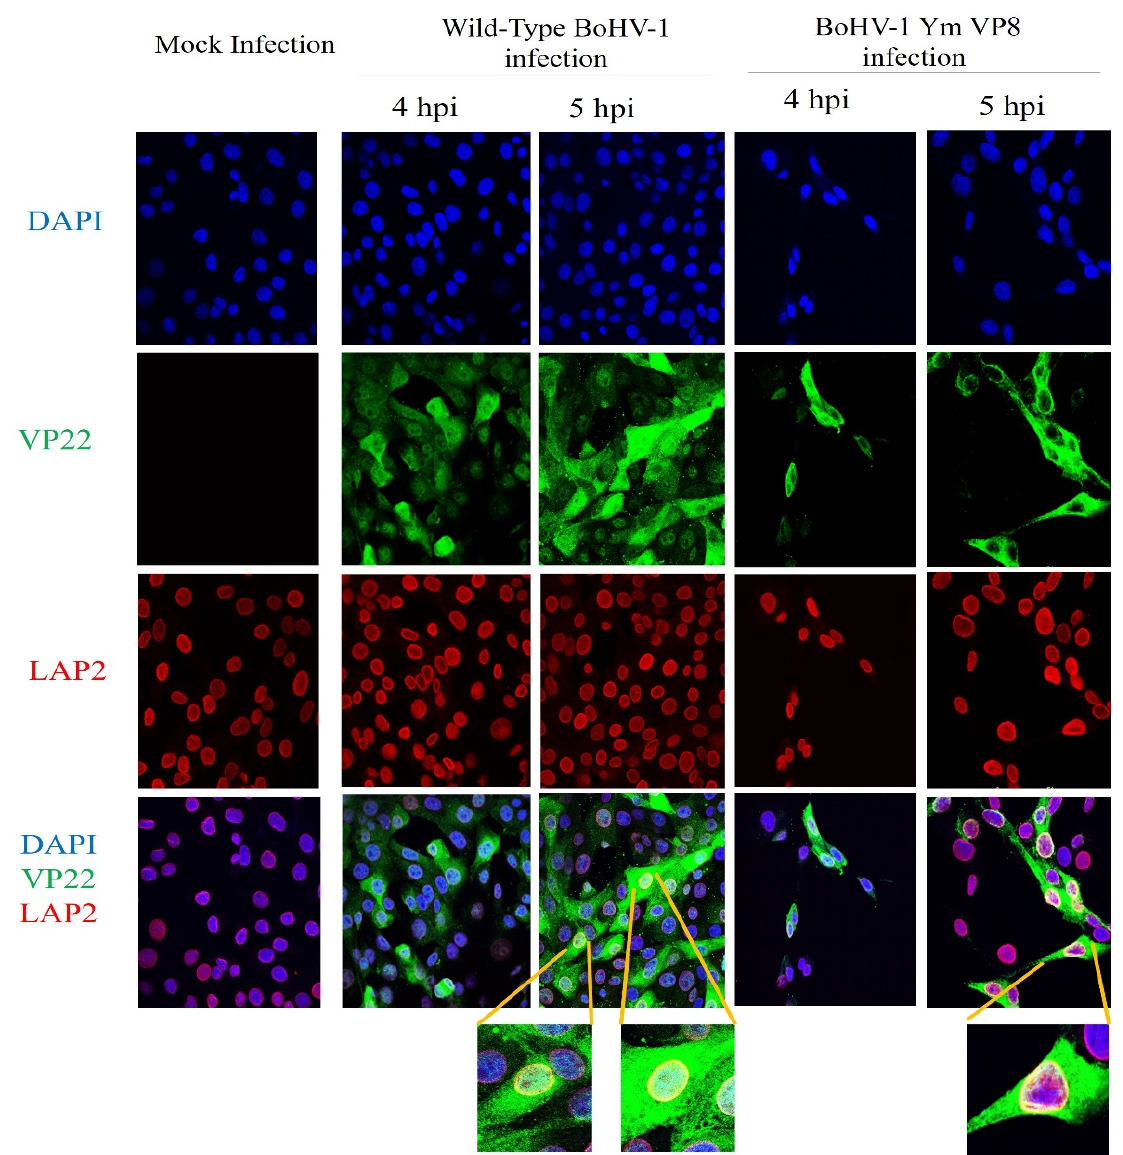
Figure 9. Localisation of VP22 in the perinuclear region. MDBK cells were infected with wild-type BoHV-1 or BoHV-1YmVP8 at MOI 5, and fixed and permeabilized 4 or 5 h post-infection. VP22 was identified with rabbit VP22-specific antibody and Alexa-488-conjugated goat anti-rabbit IgG. LAP2 was detected with monoclonal LAP2-specific antibody and Alexa-633 conjugated anti-mouse IgG. The yellow ring around the cells shows VP22 co-localised with LAP2 in the perinuclear region. Select cells were observed at 10× magnification to show more details.